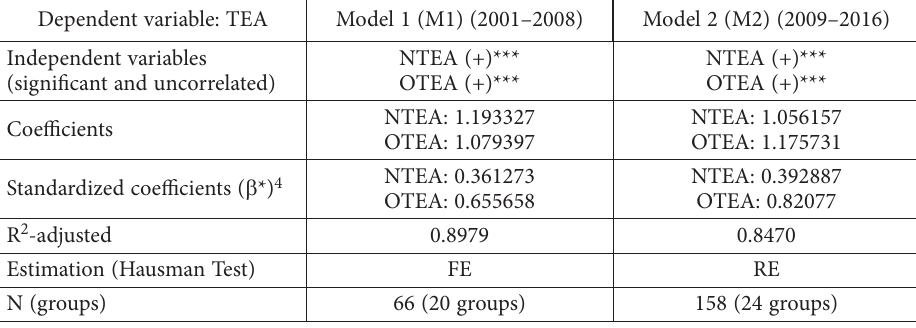
Table 4. Exploratory explanatory models of TEA by NTEA and OTEA